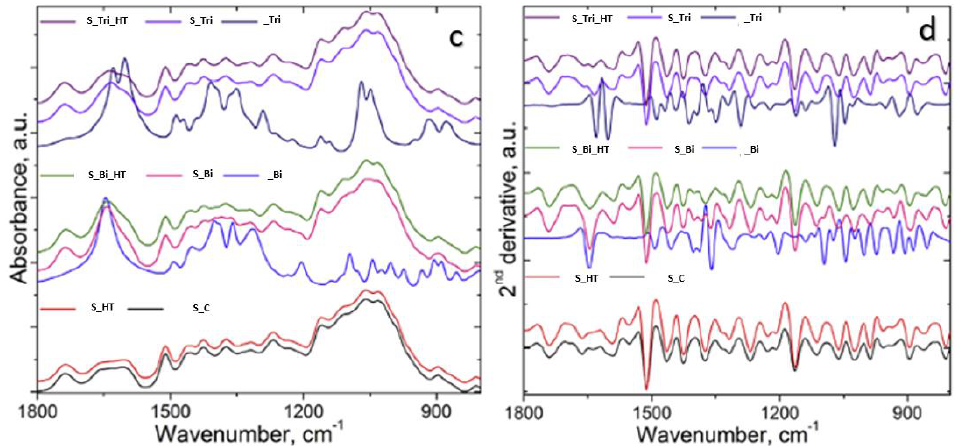
Figure 4. FTIR and 2nd derivative spectra of beech and spruce samples. ( a ) FT-IR spectra beech samples; ( b ) 2nd derivative spectra for beech samples; ( c ) FT-IR spectra spruce samples; ( d ) 2nd derivative spectra for spruce samples.